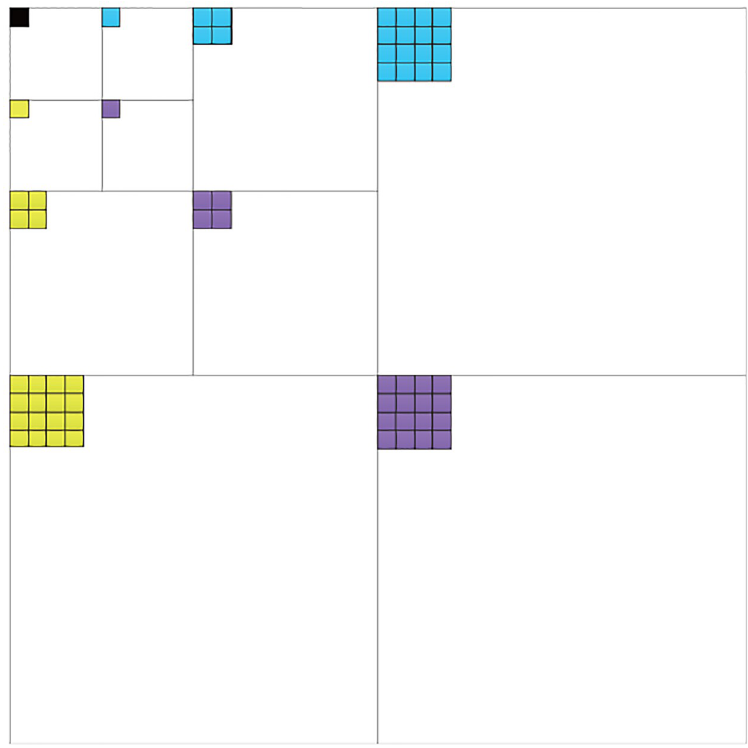
Fig 5. A spatial orientation tree in a wavelet. The coefficient colored black has no descendants; other coefficients of same colors possess branches that extend in one direction.